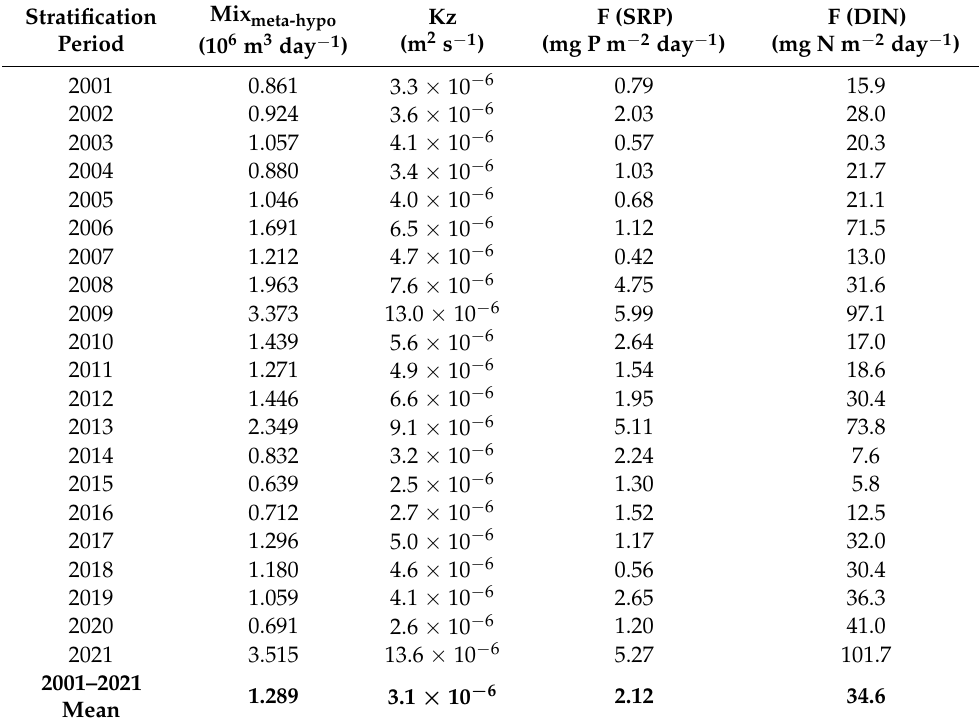
Table 1. Mean vertical water mixing rates (10 6 m 3 day − 1 ), mean vertical diffusivity coefficients, Kz